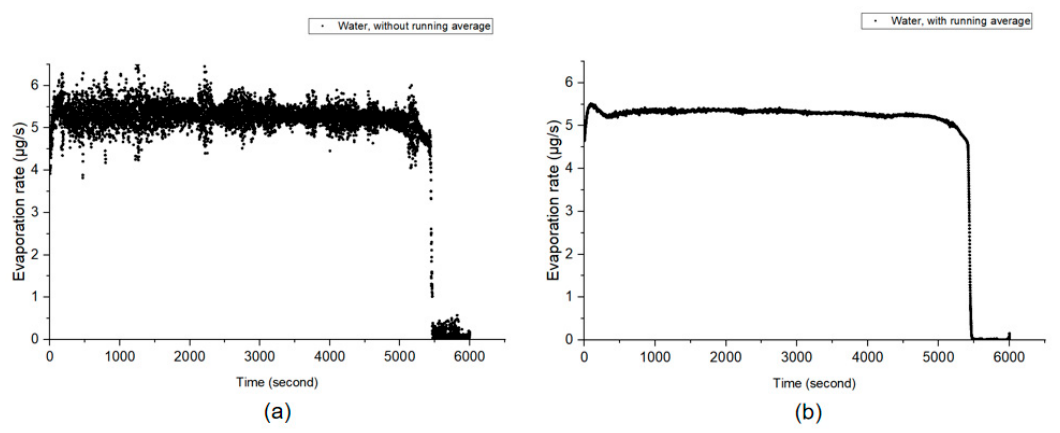
Figure 1. Evaporation rate of deionized water, ( a ) raw data ( b ) with running average.